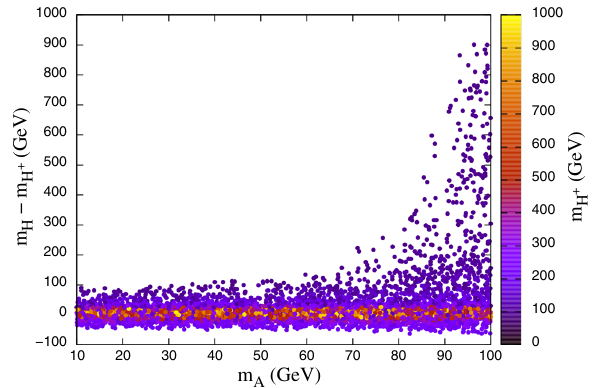
strained parameter space than the scenario when U is fixed at